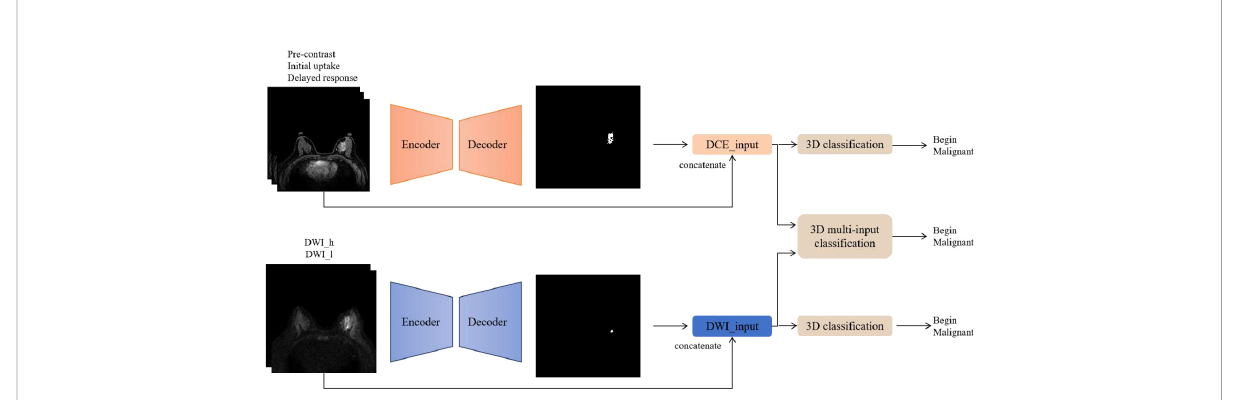
FIGURE 2 Flowchart of the deep learning algorithm. DCE and DWI were respectively input into the AI model to obtain lesion segmentation results and preliminary diagnosis. Then, the images from the two sequences were integrated and input into the 3D multi-input model to obtain the ultimate